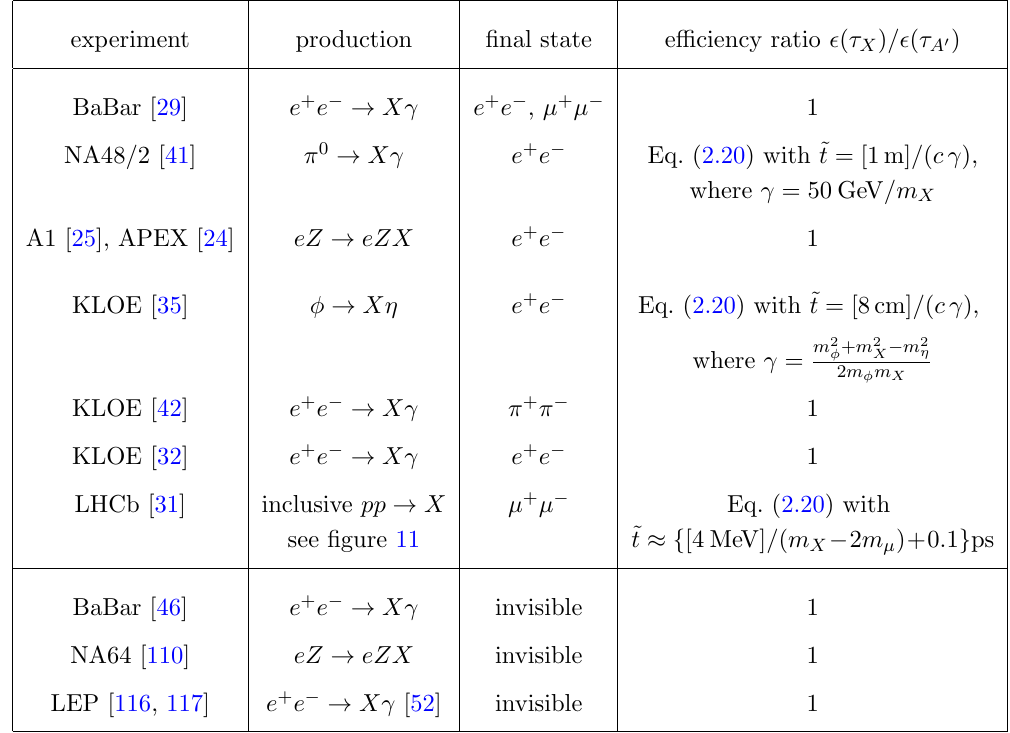
Table 4 . Summary of experiments that searched for prompt or invisible A 0 decays. See ap-